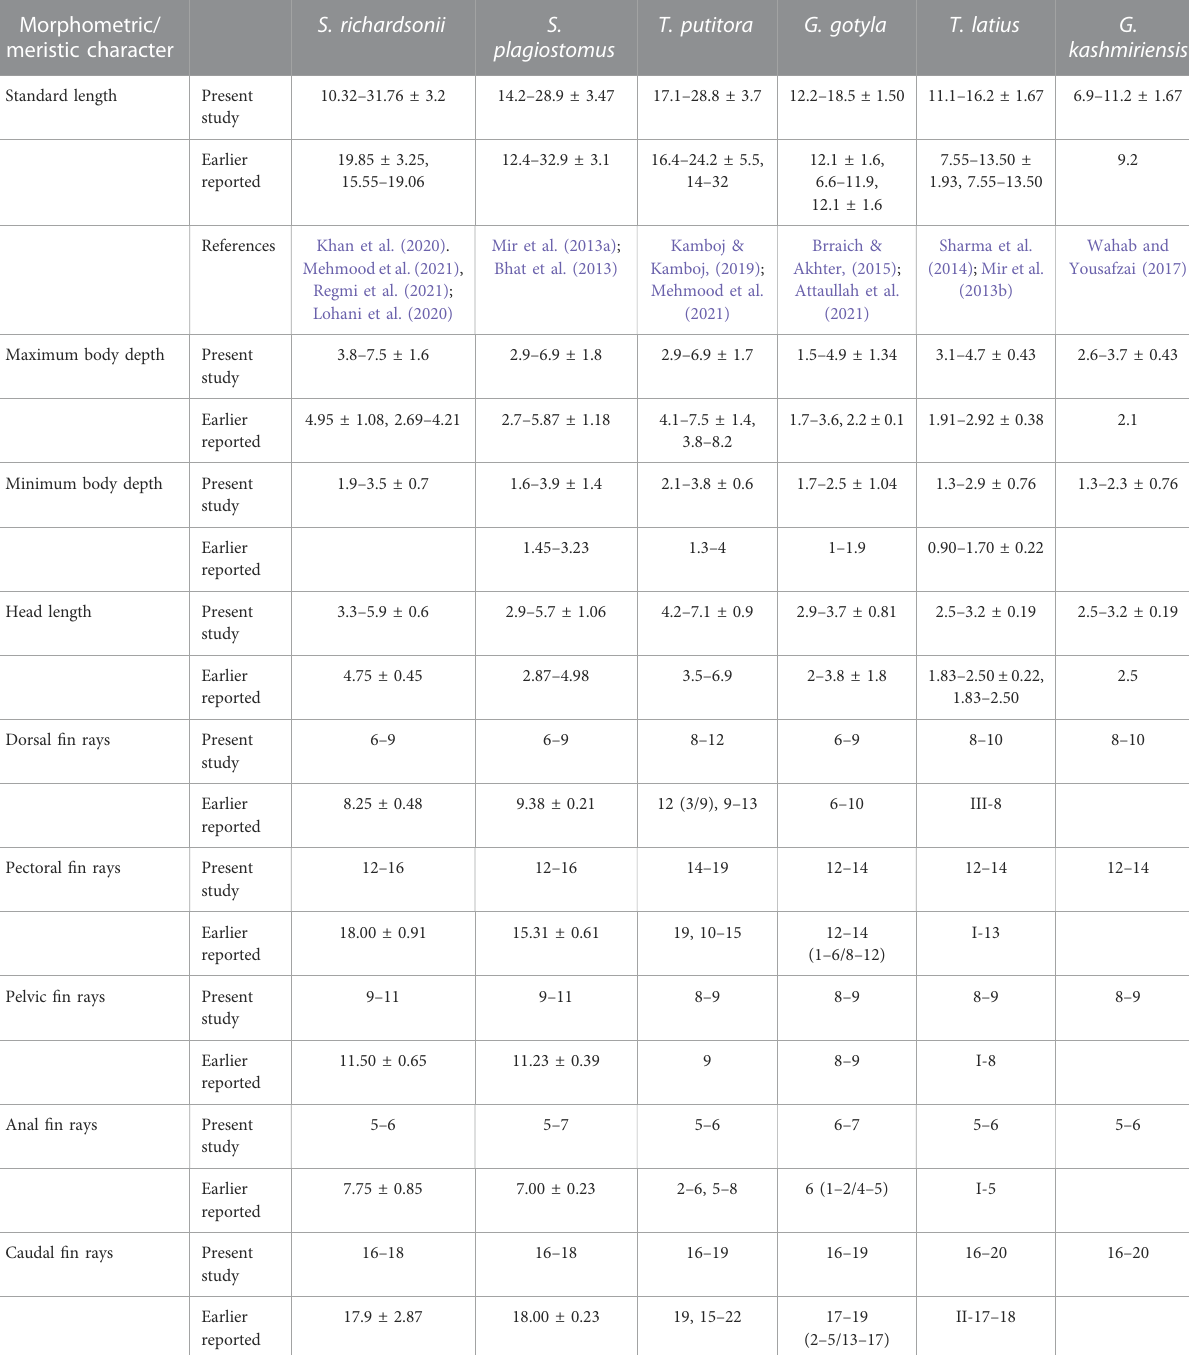
TABLE 2 Comparative analysis of some important phenotypic characters of six fi sh species habiting River Poonch with already published data. Morphometric/ meristic